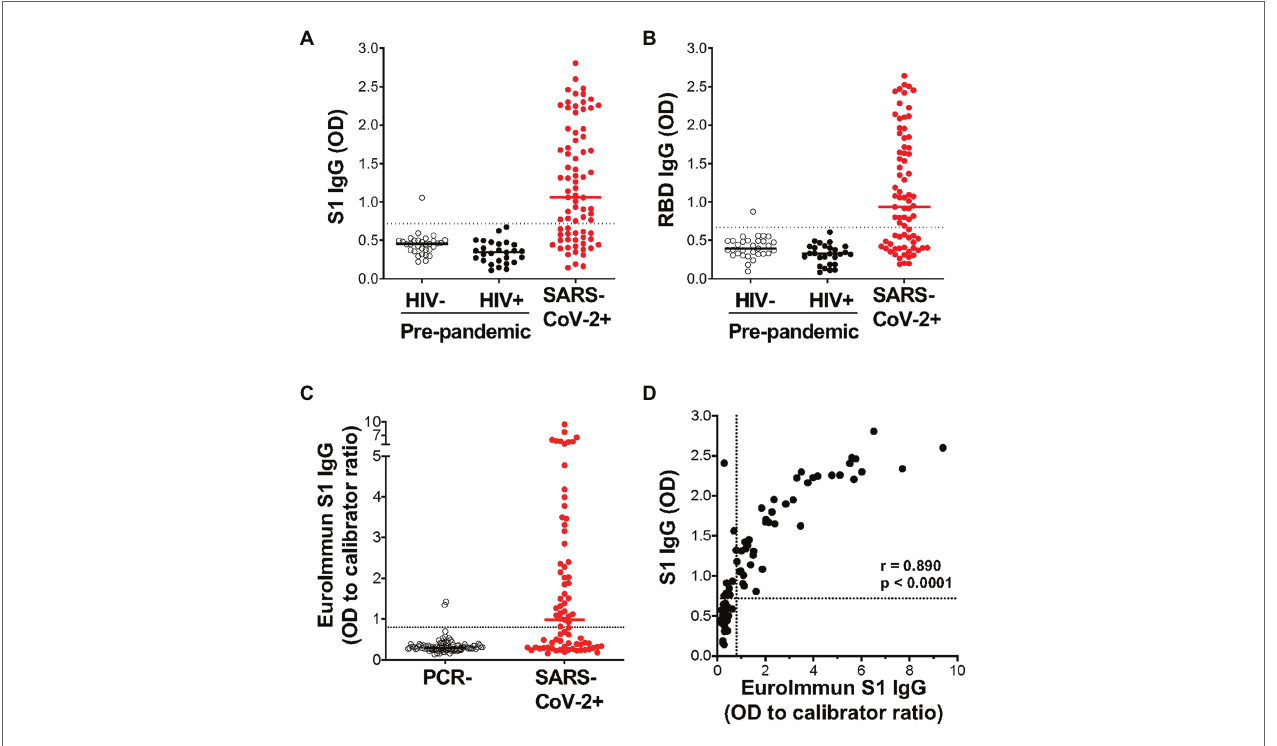
FIGURE 3 | Detection of IgG using plant-expressed SARS-CoV-2 spike antigens in COVID-19 convalescent volunteers and pre-pandemic controls using an in- house ELISA. Reactivity to plant-expressed S1 (A) and RBD (B) in pre-pandemic samples from HIV-uninfected individuals ( n = 31), HIV-infected individuals ( n = 27), and SARS-CoV-2 PCR positive volunteers ( n = 77). Dotted lines indicate threshold for positivity, calculated as the mean optical density (OD) + 2SD of the pre- pandemic samples. (C) Reactivity in Euroimmun IgG S1 of the same SARS-CoV-2 PCR positive volunteers ( n = 77) and a set of PCR negative sera ( n = 101). Results are expressed as OD to calibrator ratio, as per the manufacturer’s recommendations. The dotted line is at 0.8, above which samples are indeterminate or borderline (>0.8 and <1.1) or positive (>1.1). (D) Correlation of the OD values for S1-specific IgG in our in-house ELISA and the commercial Euroimmun IgG S1 ELISA assay. Statistical analyses were performed using a non-parametric Spearman rank correlation. Each dot represents one